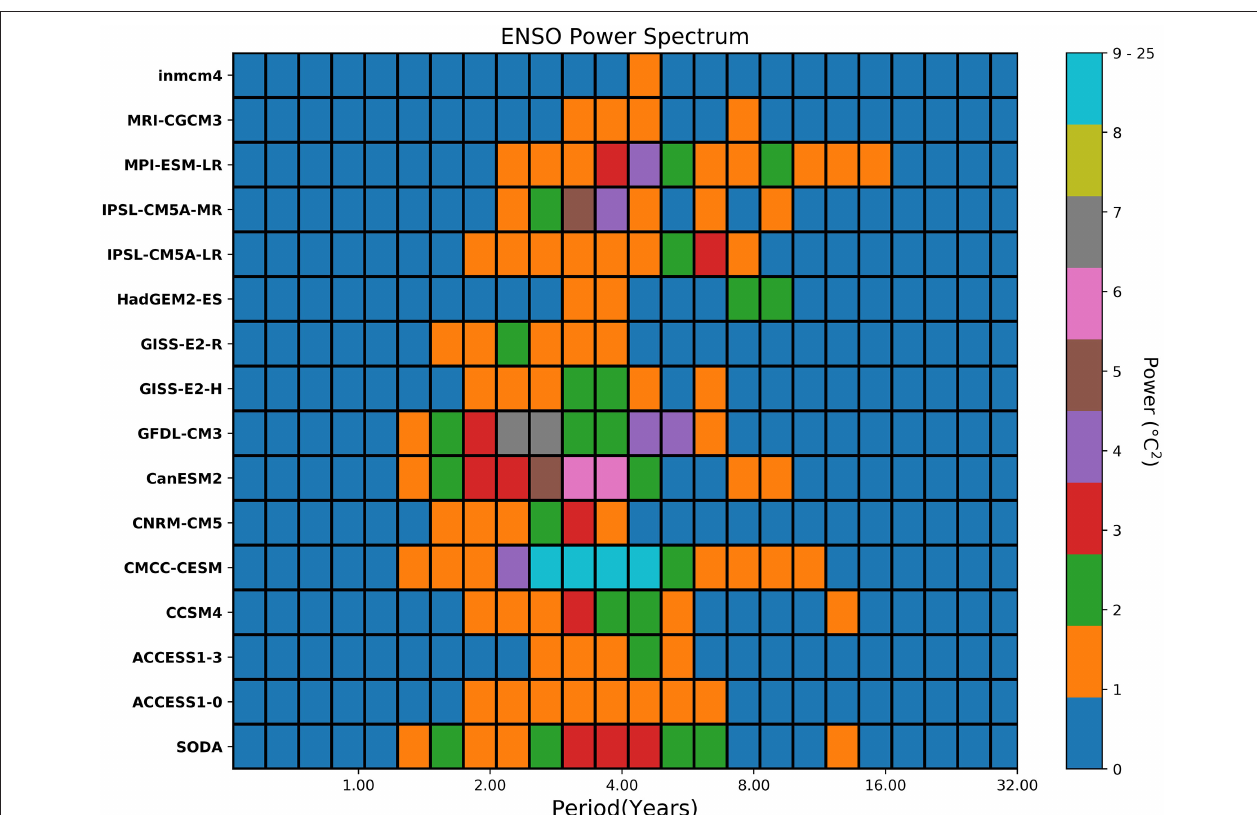
FIGURE 7 | Power spectrum of Niño3.4 index during 1967–2005 for models and during 1980–2018 for SODA reanalysis. The period (in years) is on the x-axis and the power is shaded.